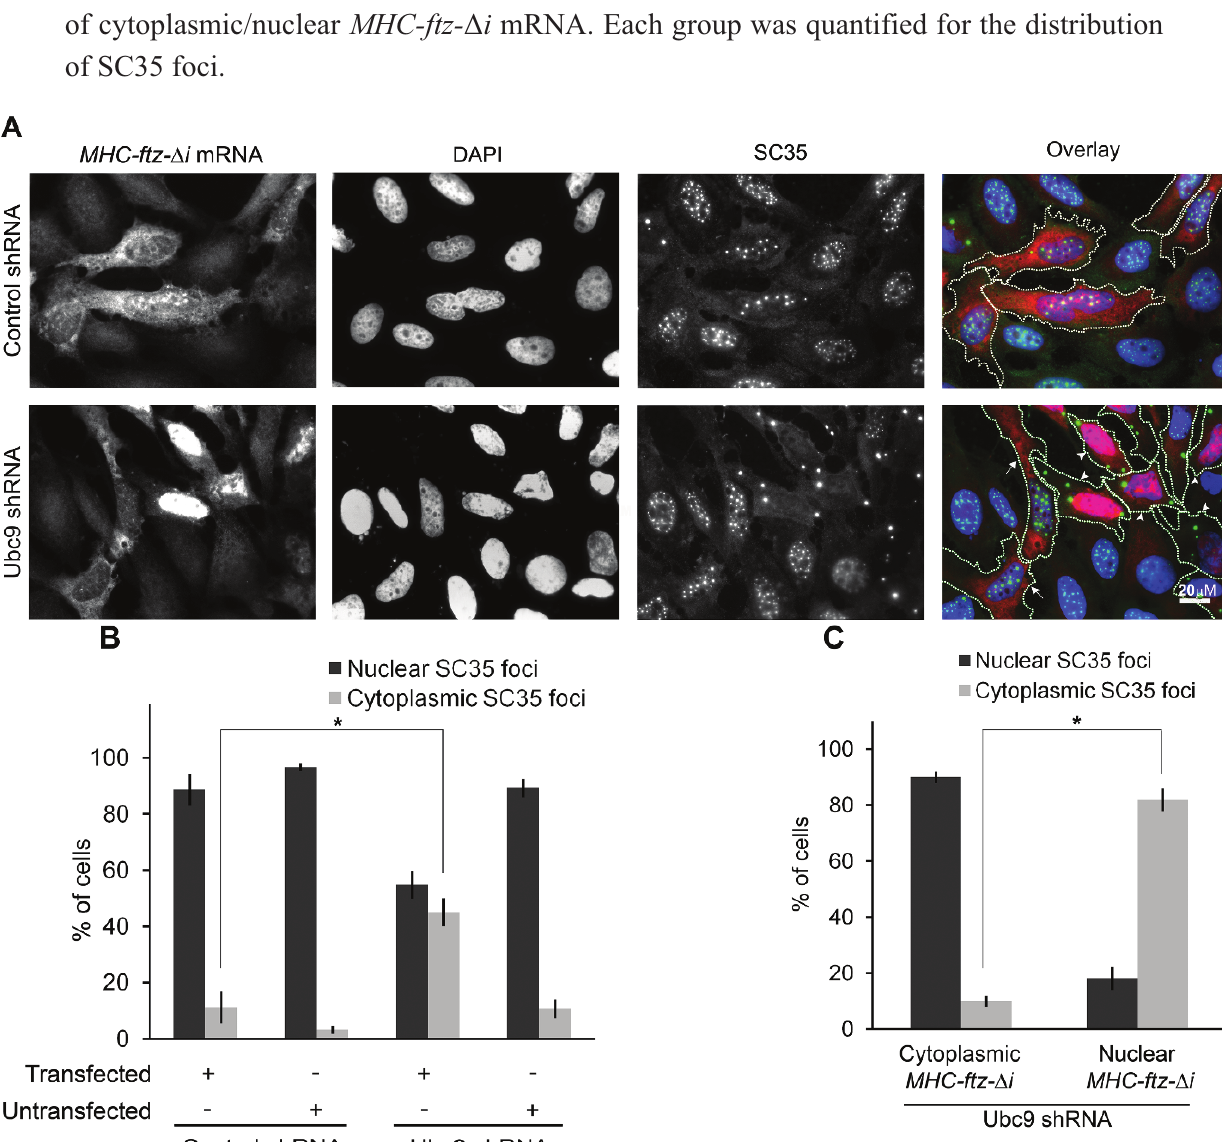
Figure 5. Expression of MHC-ftz- (cid:2) i in Ubc9-depeled cells causes SC35 mislocalization. U2OS cells were treated with lentivirus containing shRNAs targeting Ubc9 or control shRNA as in Figure 1. Four days post-infection, the cells were transfected with MHC-ftz- (cid:2) i reporter plasmid DNA. The cells were allowed to express the mRNA for 18–24 h; then they were fixed and stained for ftz mRNA by FISH and SC35 by